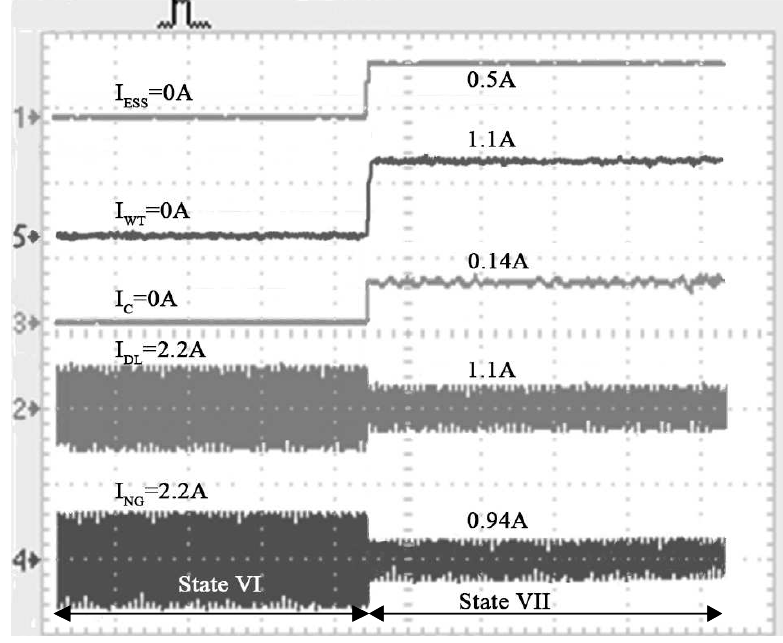
Figure 32. Experimental result for states VI and